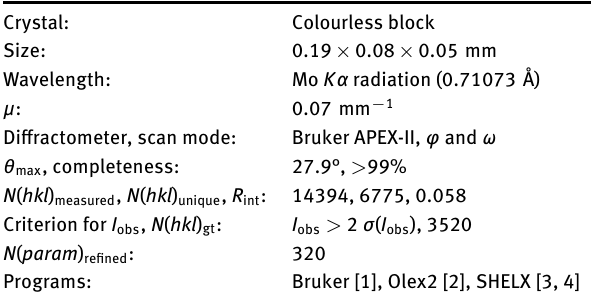
Table 1: Data collection and